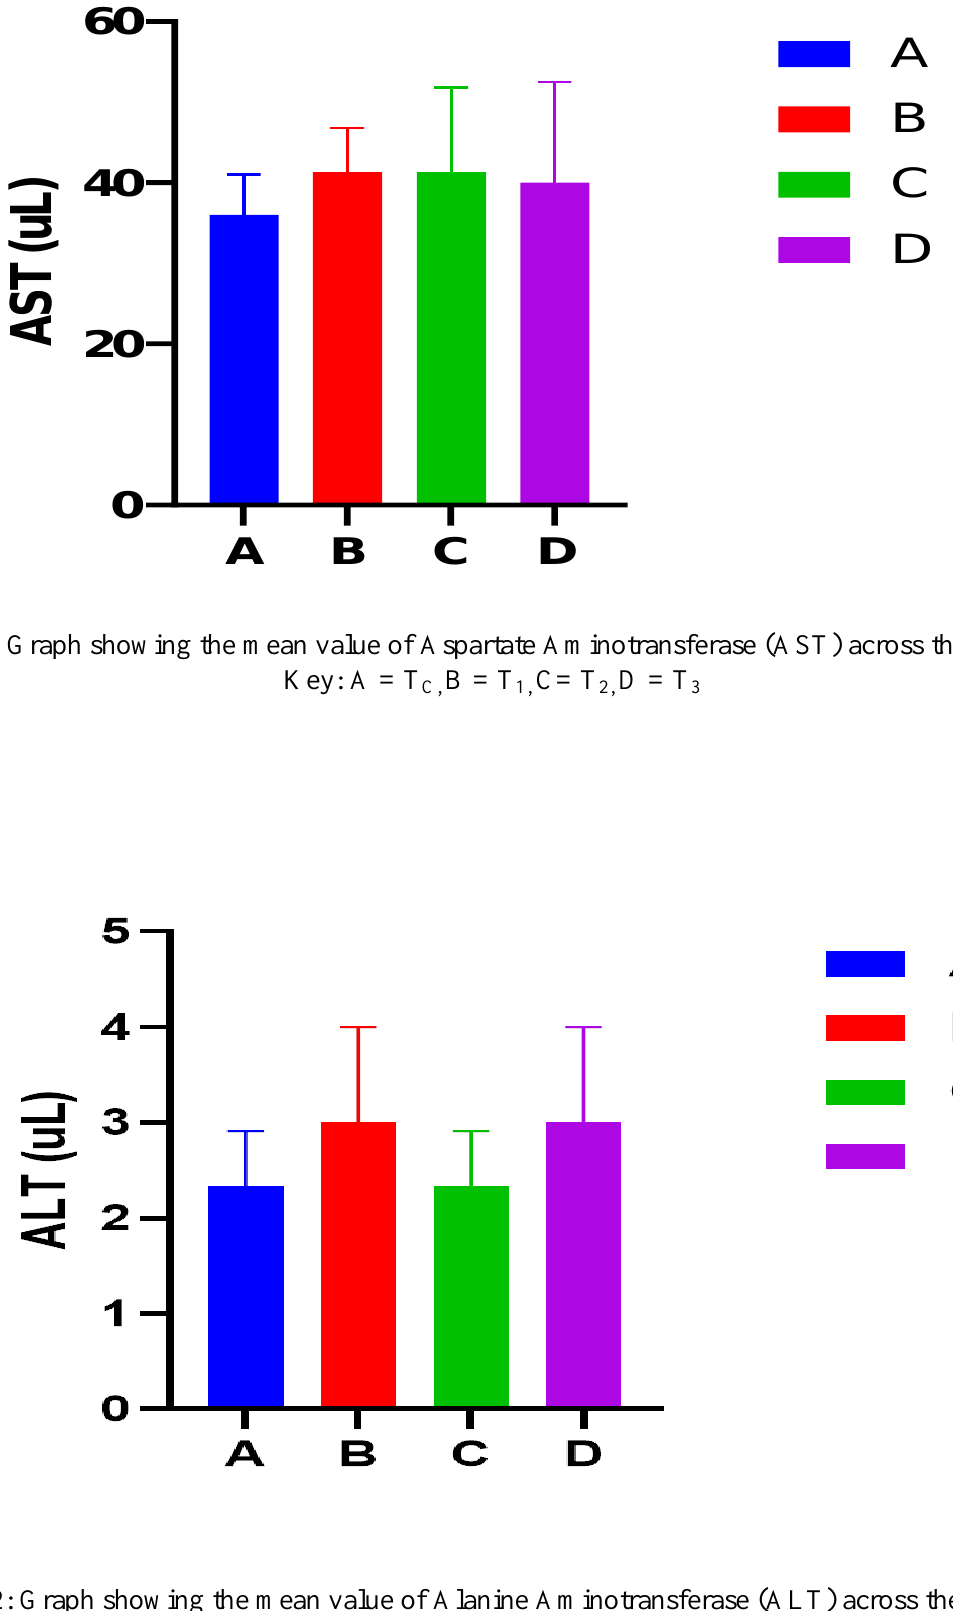
Key: A = T B = T C= T D = T C, 1, 2,